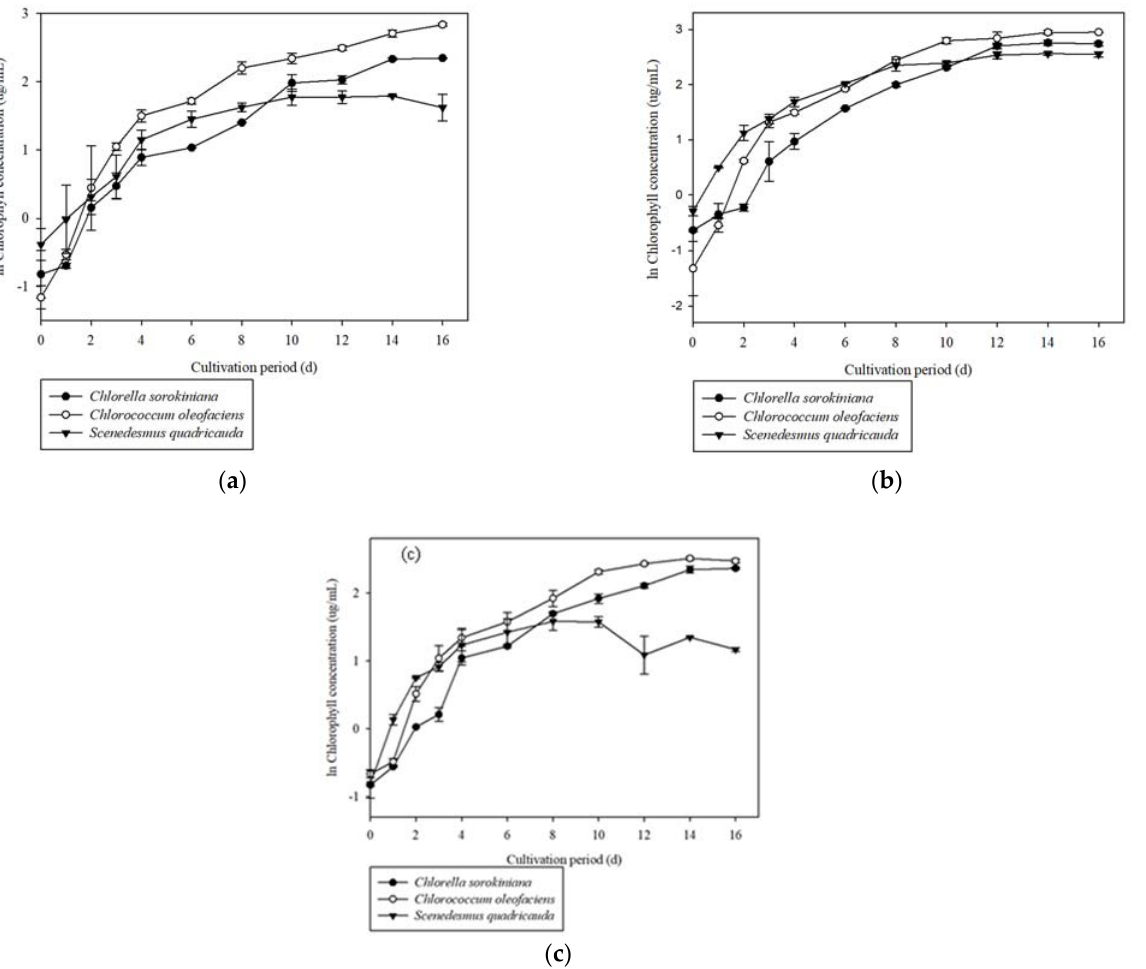
Figure 2. Growth profile of Chlorococcum oleofaciens , Chlorella sorokiniana , and Scenedesmus quadricauda over 16 days in ( a ) 25%, ( b ) 50%, and ( c ) 75% dilution of LAB-POME. The specific growth rate of C. oleofaciens , C. sorokiniana , and S. quadricaudatus